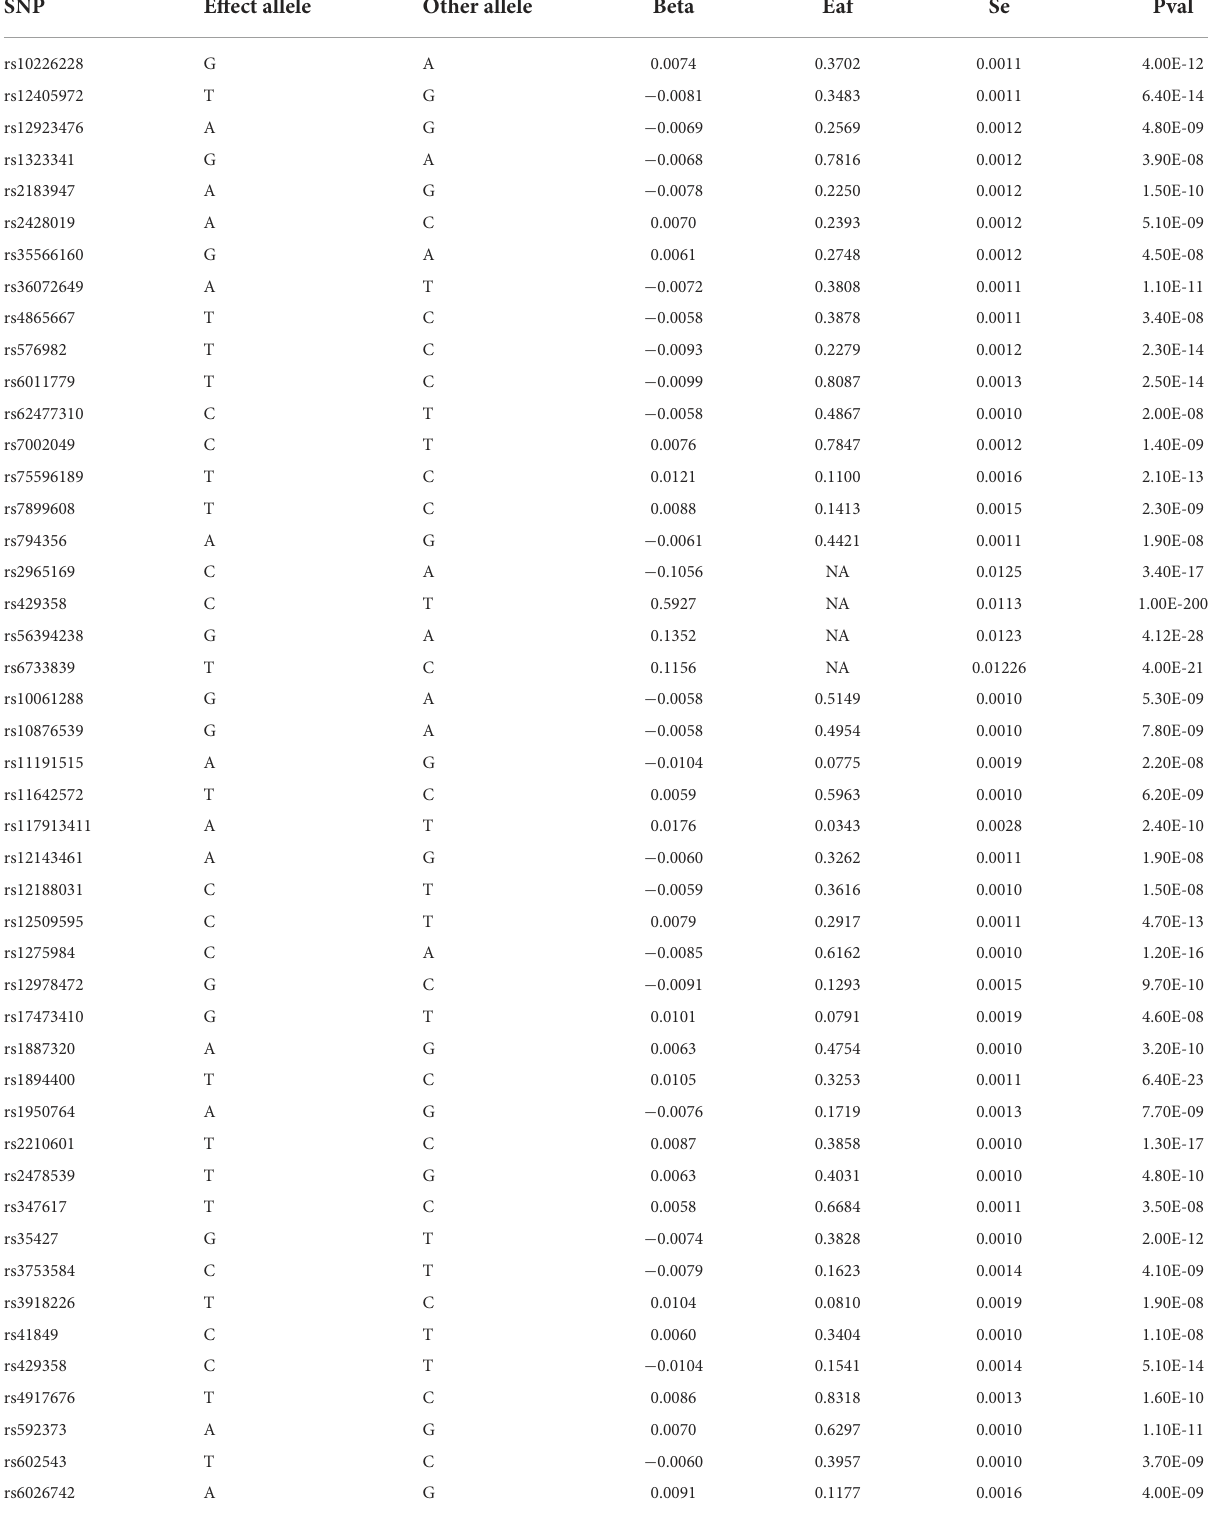
TABLE 2 Basic information on SNPs associated with maternal smoking around birth and maternal